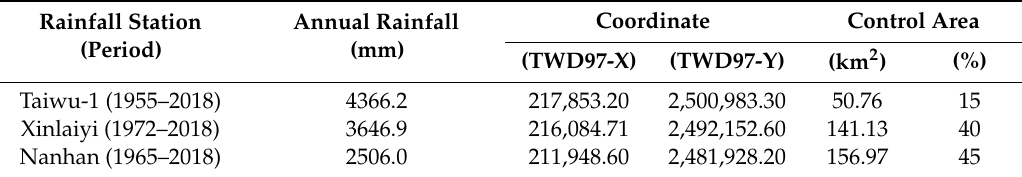
Table 2. Information about each groundwater monitoring well in the study